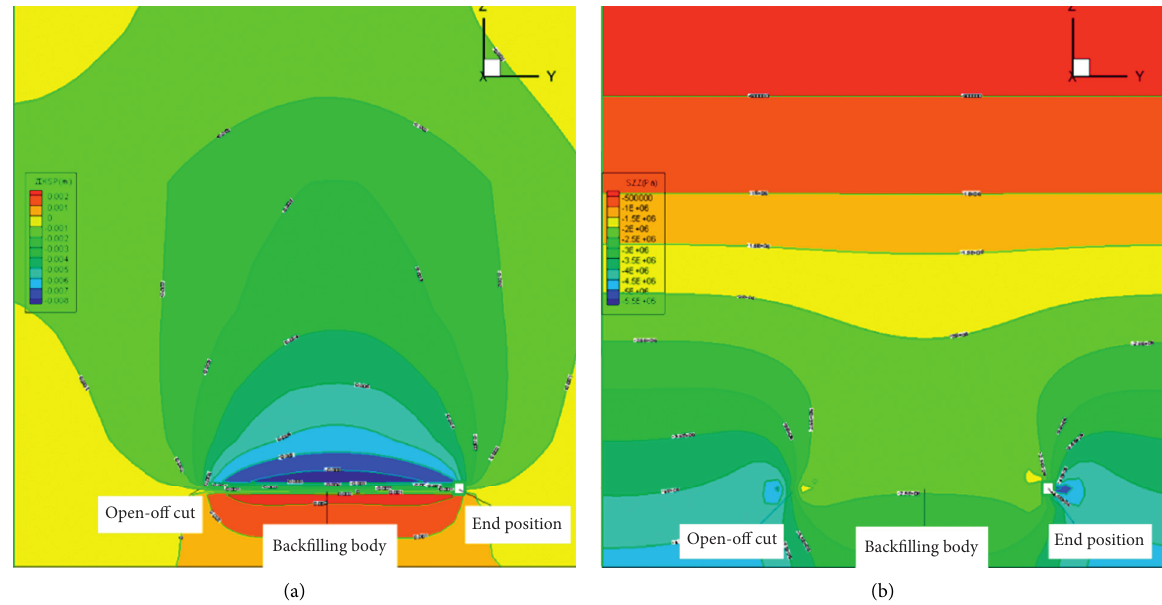
Figure 10: Movement of overlying strata when the working face advances for 100m under the elastic modulus of gangue of 1GPa. (a) Displacement vector of surrounding rock. (b) Distribution of vertical stress.